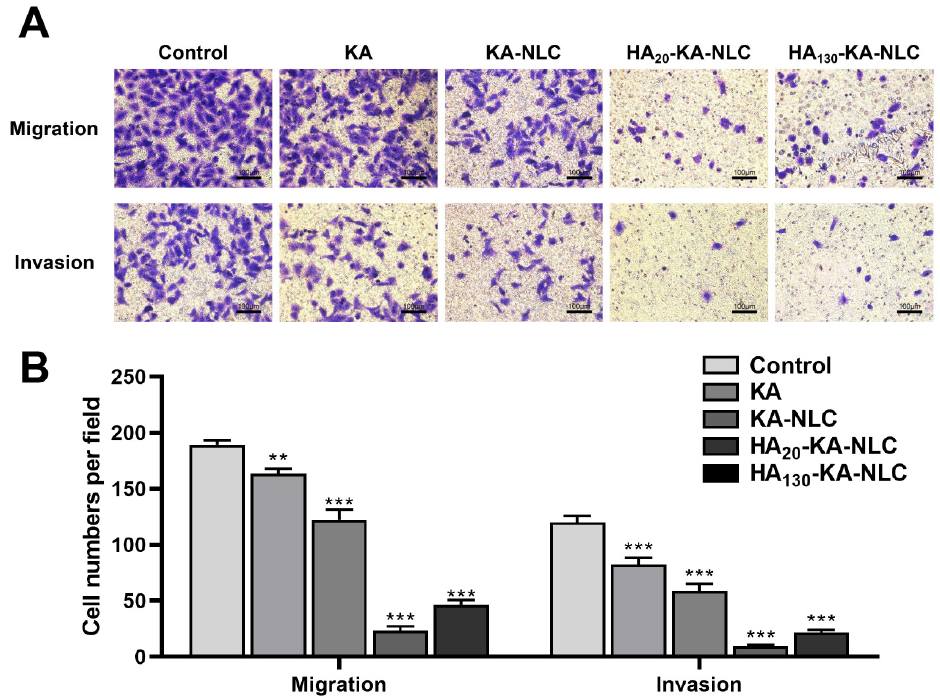
Figure 11. Transwell assay conducted on A549 cells without treatment or with KA, KA-NLC, HA 20 - KA-NLC, and HA 130 -KA-NLC treatments. ( A ) Representative images of migration and invasion assay. ( B ) Number of migratory or invasive cells per field after different treatments. The data are presented as the mean ± SD ( n = 3). ** p < 0.01, *** p < 0.001.